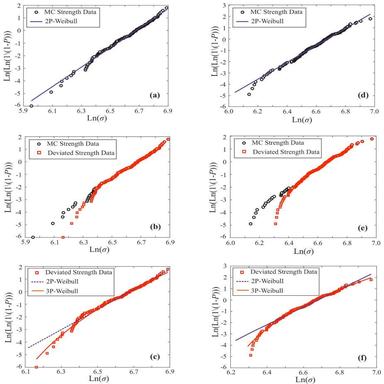
Two examples (a–c) and (d–e) that show Weibull plot of generated strength data, deviated strength data and fit of deviated strength data with 2P-and 3P-Weibull distribution functions.